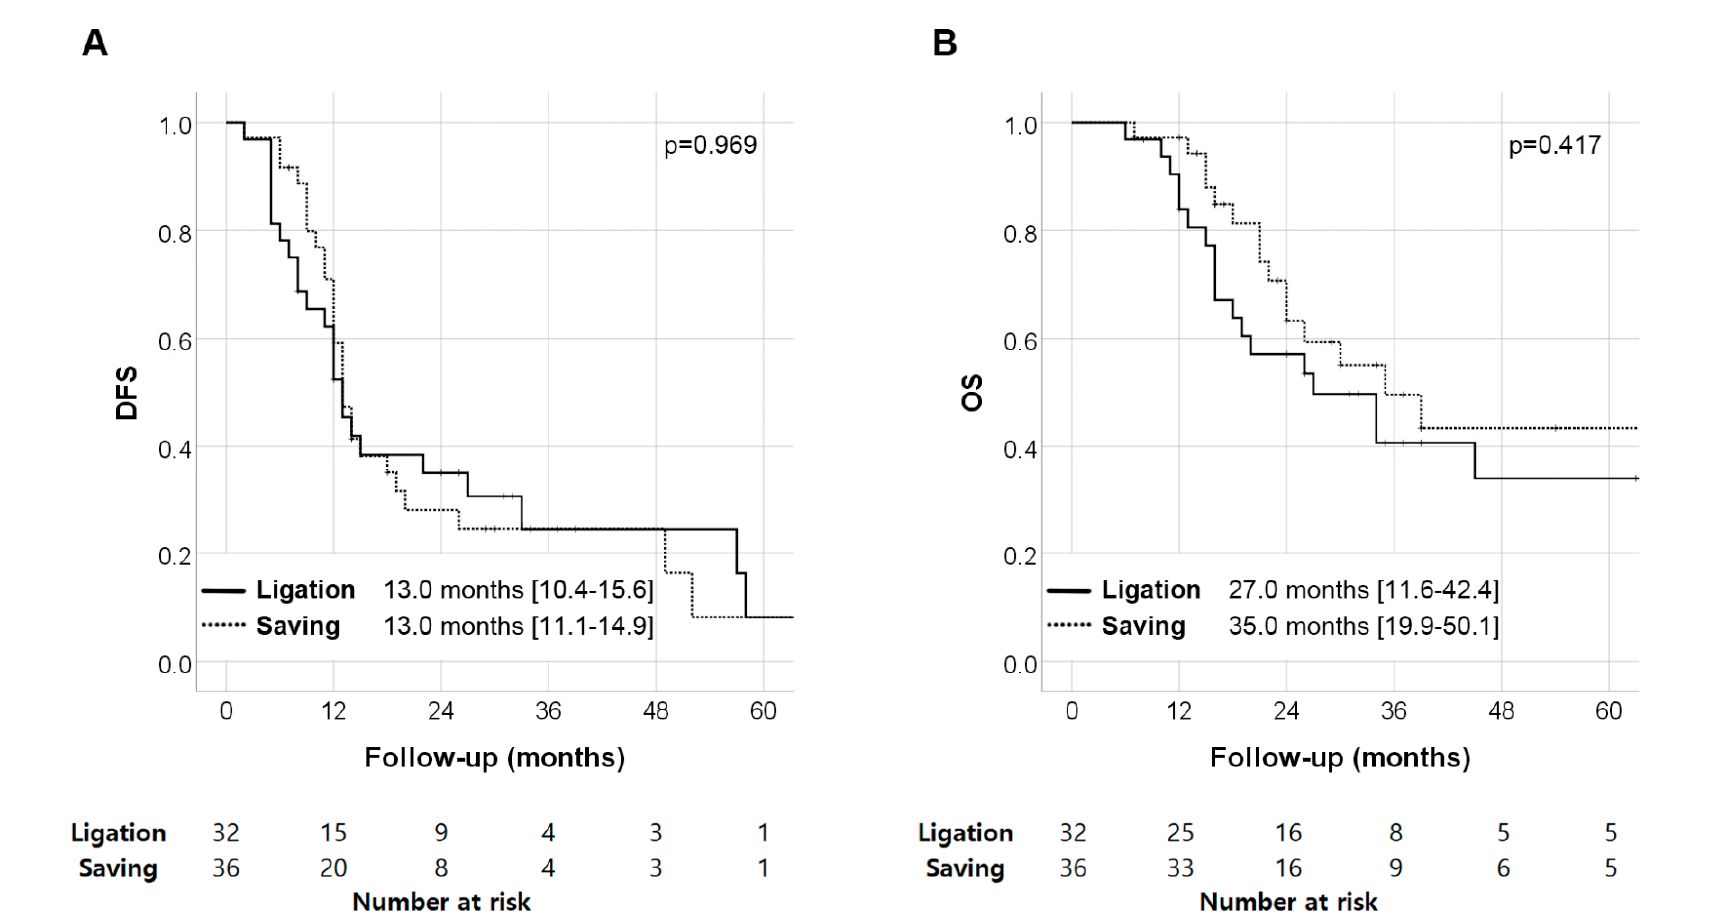
Figure 2. Survival analyses according to splenic vein status: ( A ) disease-free survival and ( B ) overall survival.